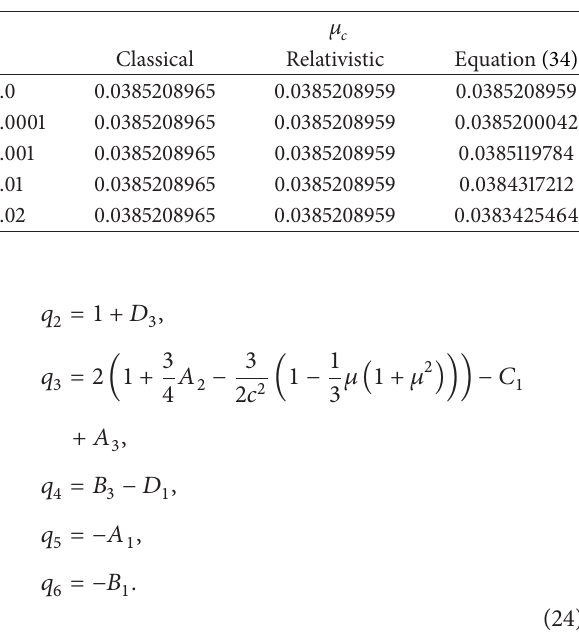
Table 4: Critical Mass. Sun-Mars system: 𝑐 = 22247.35 , 𝜇 = = 0.0000000001 × 10 −8 0.000000322700 , and 𝐴 2